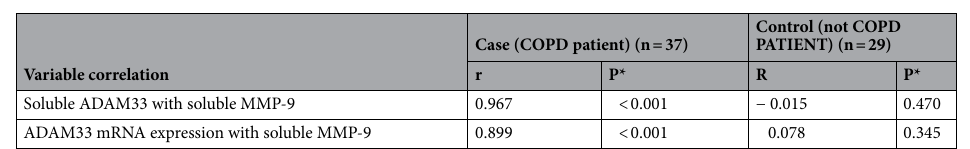
Case (COPD patient) (n = 37)